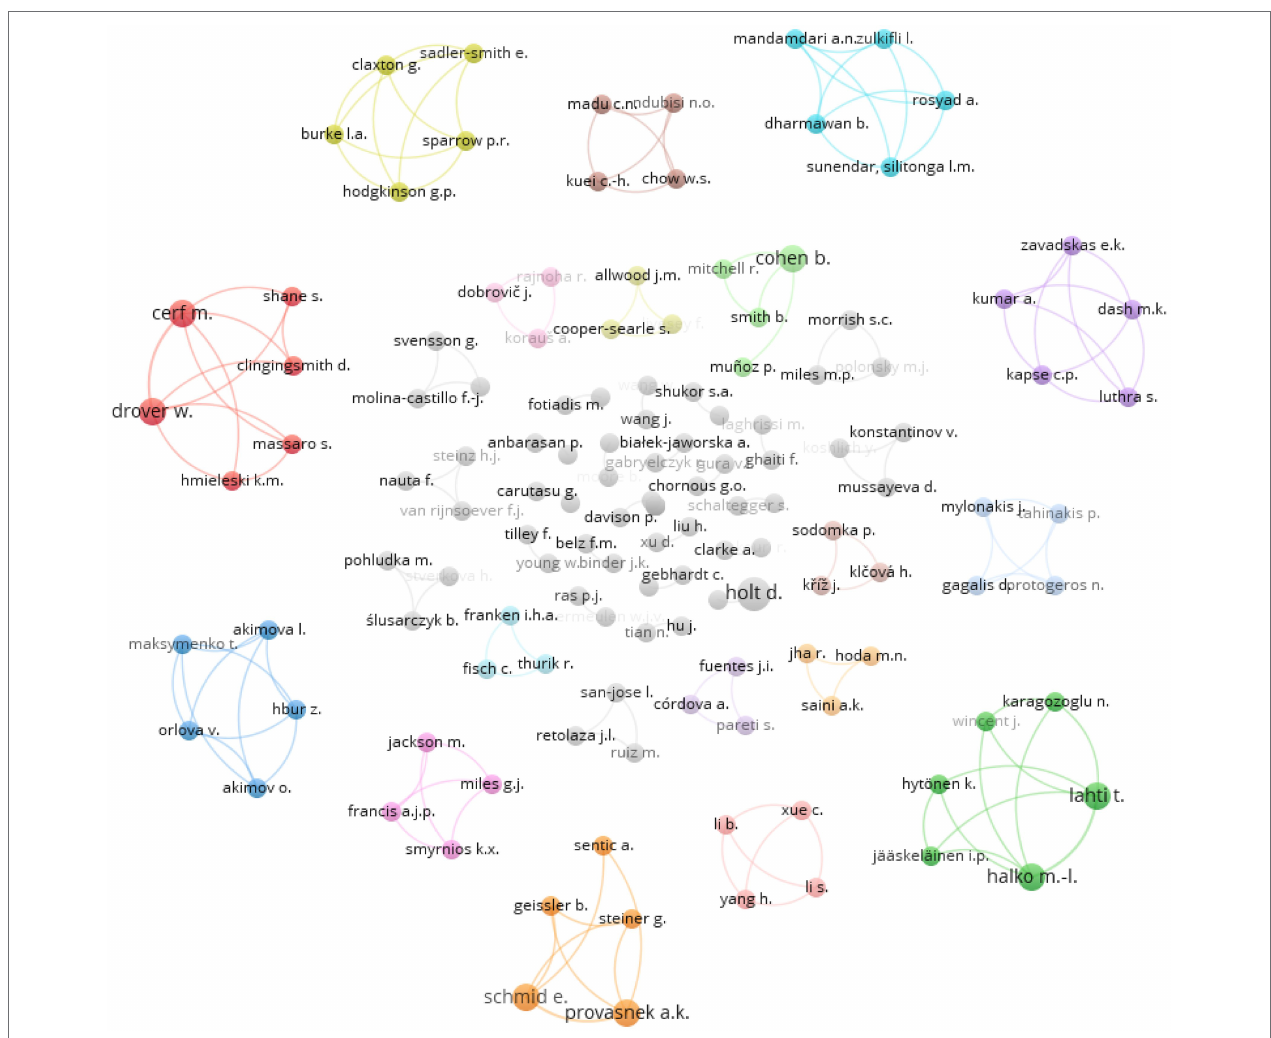
FIGURE 4 | Authors’ cooperation network, 1999–2021.